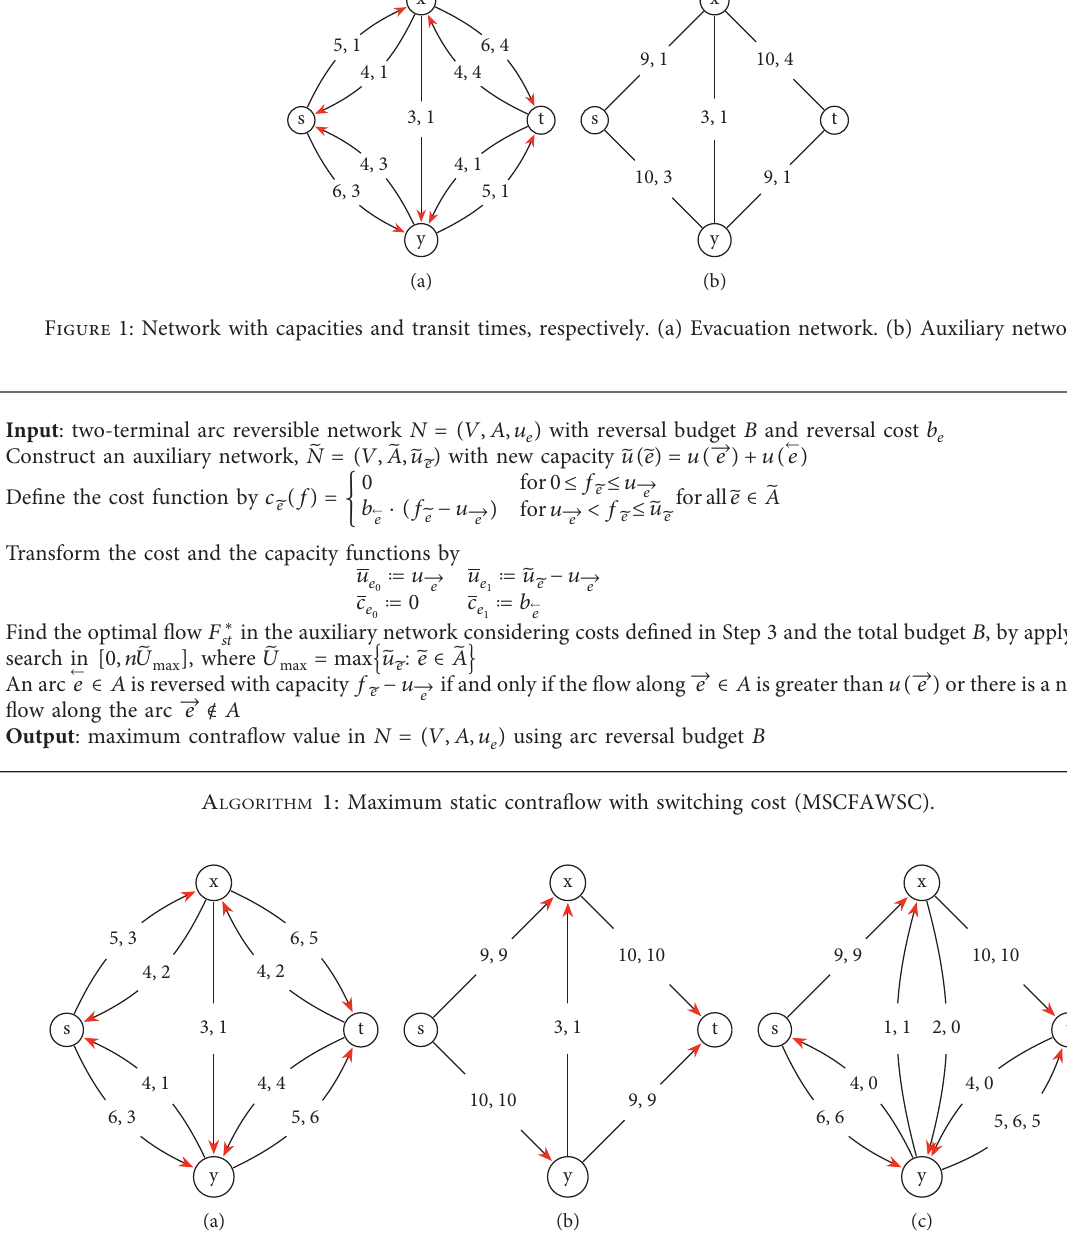
Figure 2: Evacuation network, contraflow without budget constraint and contraflow with budget constraint, respectively. (a) Capacity, unit cost. (b, c) Capacity,